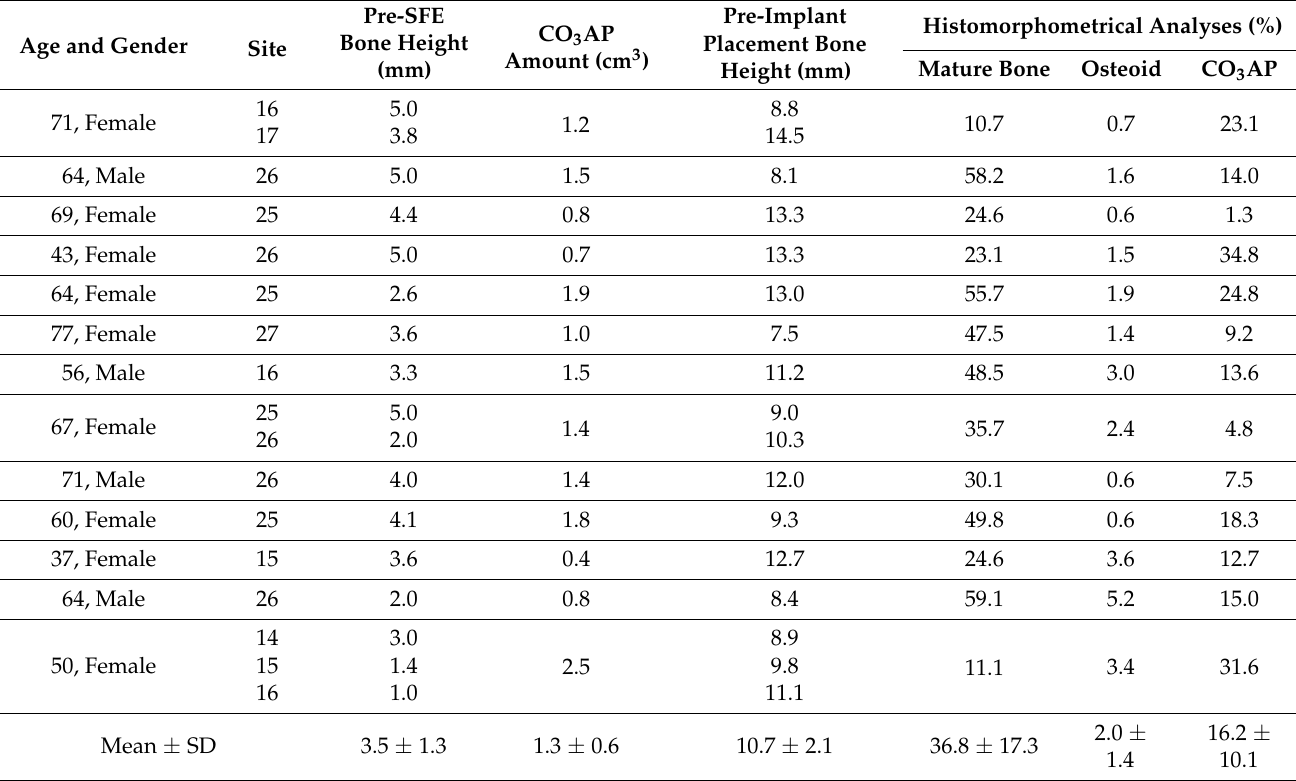
Table 2. Patient’s profiles and the data of SFE and bone